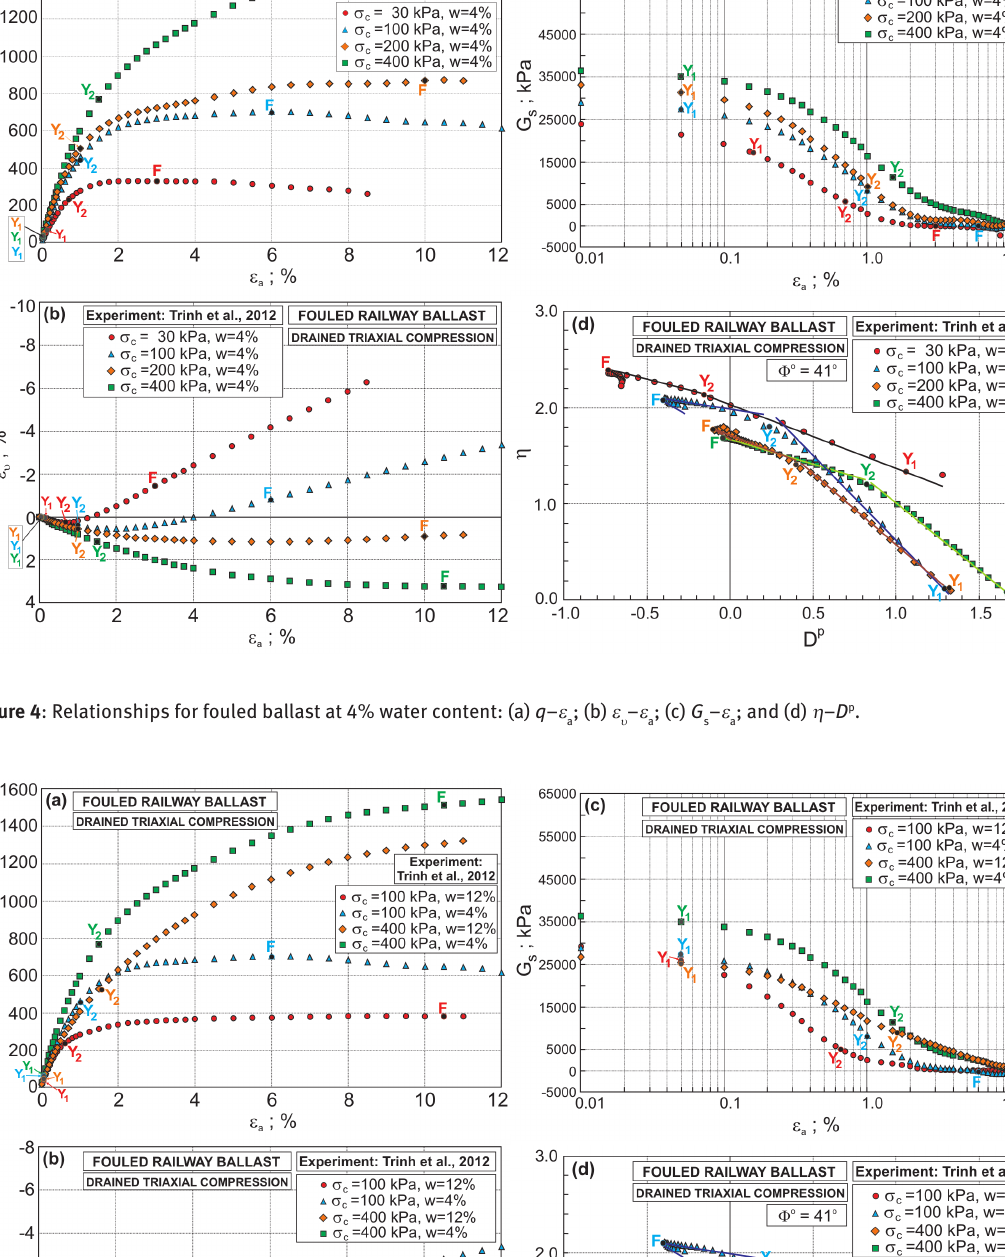
; (b) e – e ; (c) G – e ; and (d) h – D p u a a s a